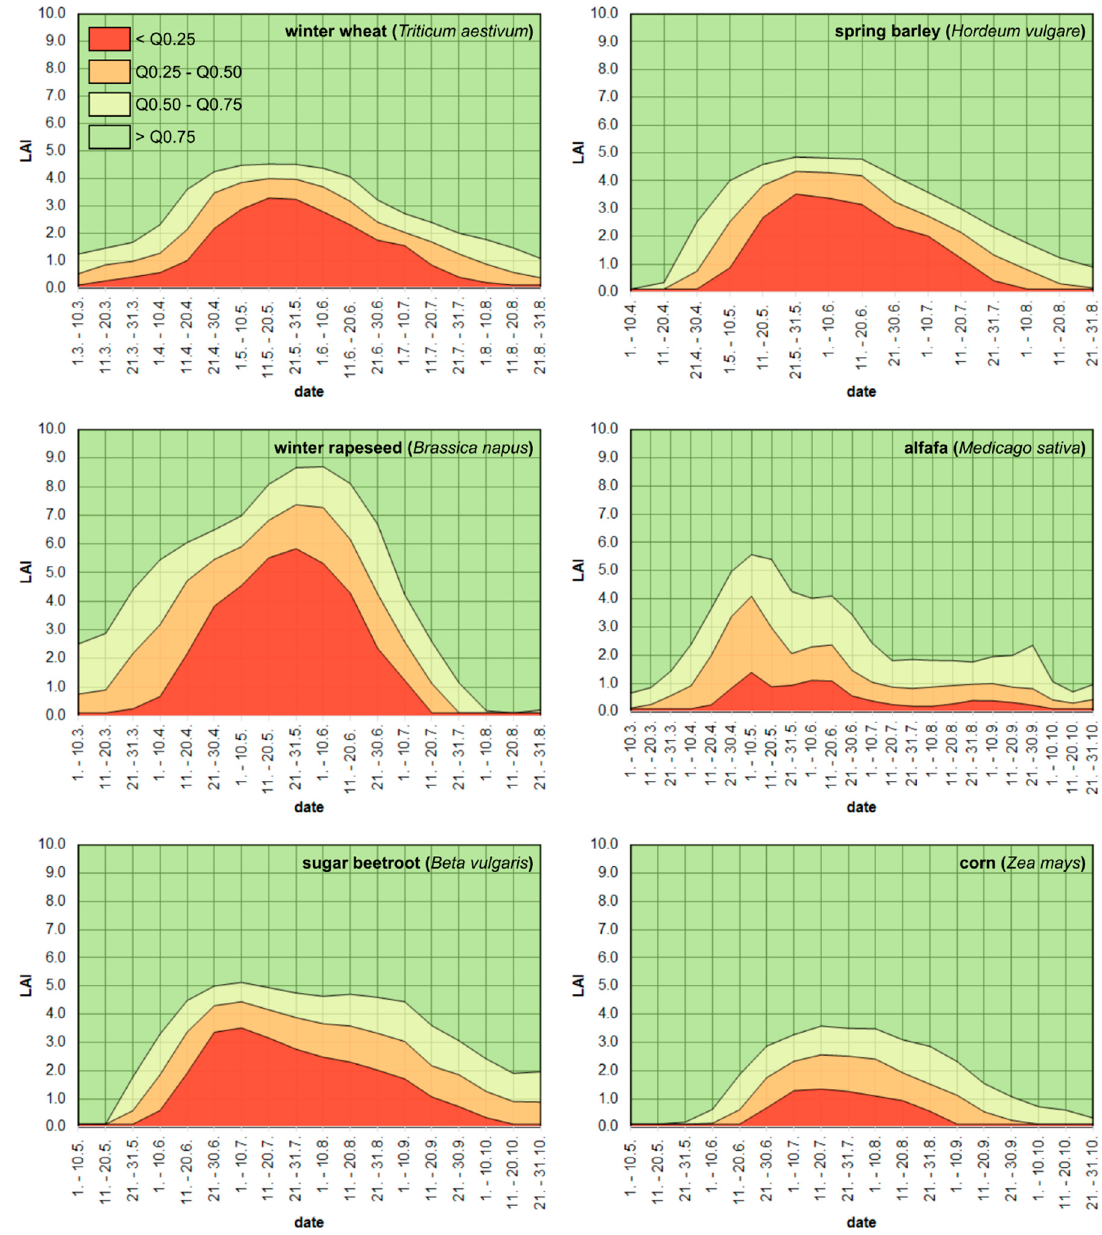
Figure A4. Temporal changes in estimated leaf area index (LAI) values for all six crops of interest demonstrated using Q0.25, Q0.50, and Q0.75 quantiles.